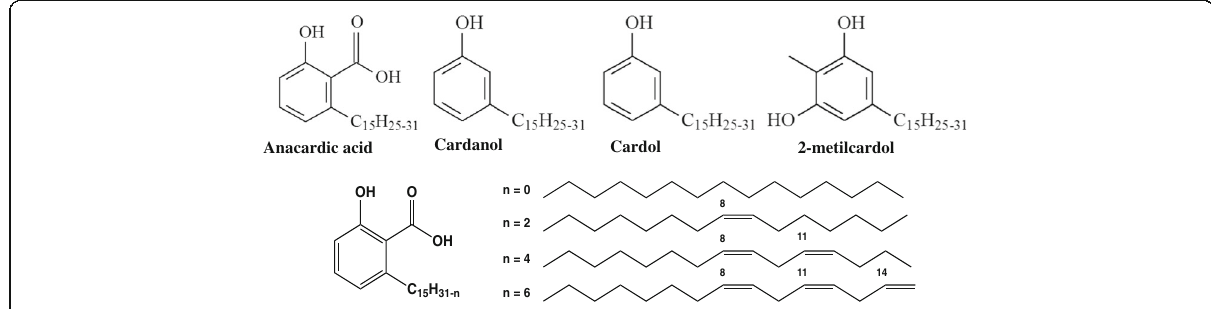
Fig. 1 Non-isoprenoid phenolic lipid constituent of the